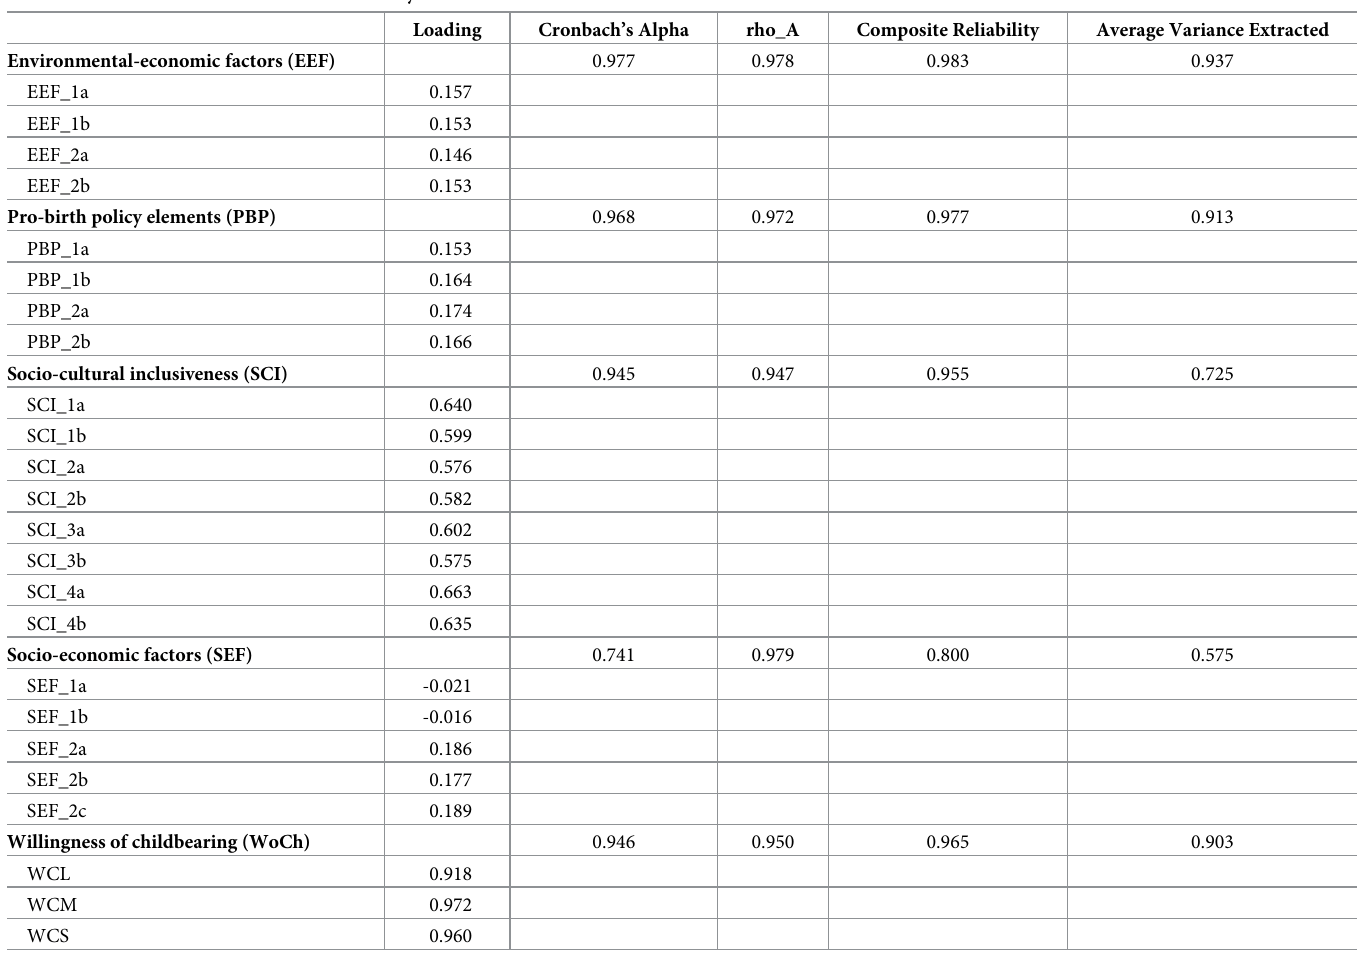
Table 2. Results of the measurement model analysis.